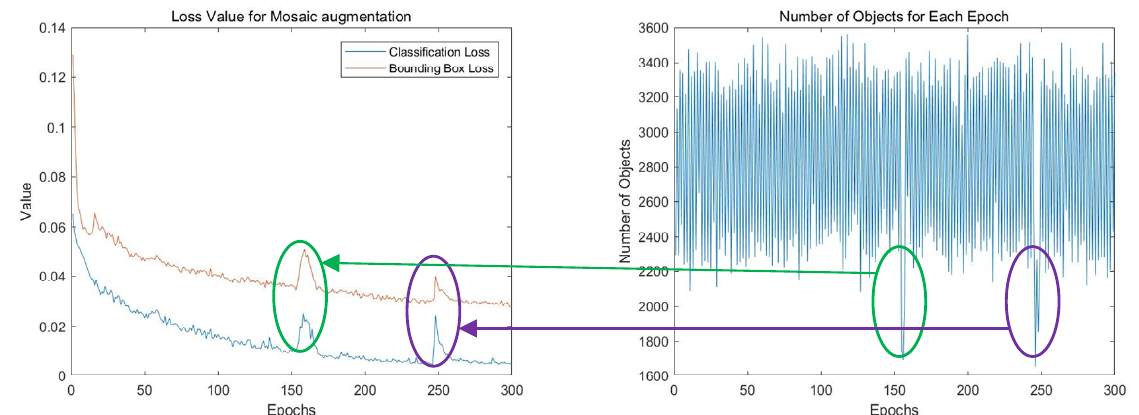
Figure 5. Sparse object dataset leads to unstable training procedure.